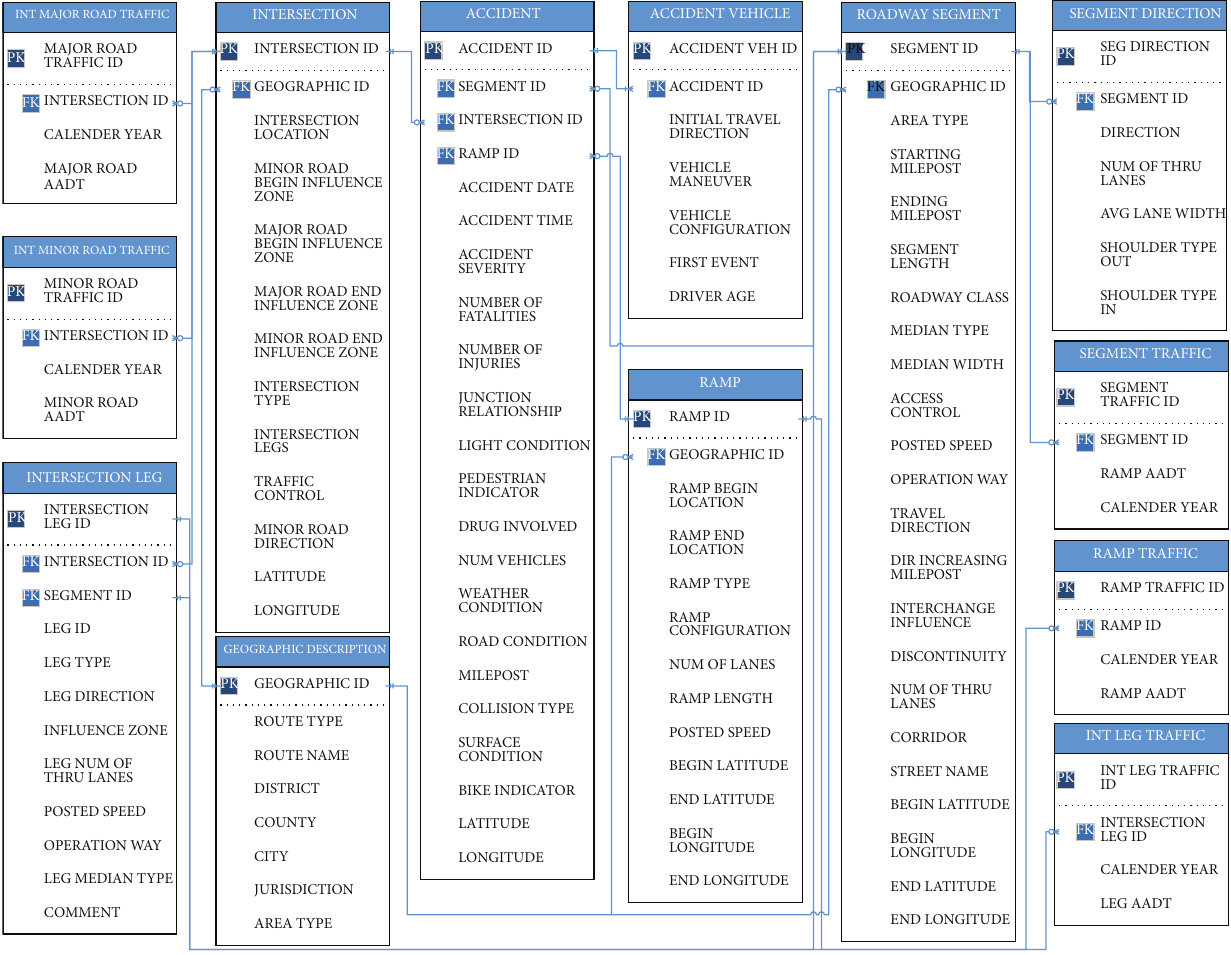
Figure 4: A physical data model for the safety